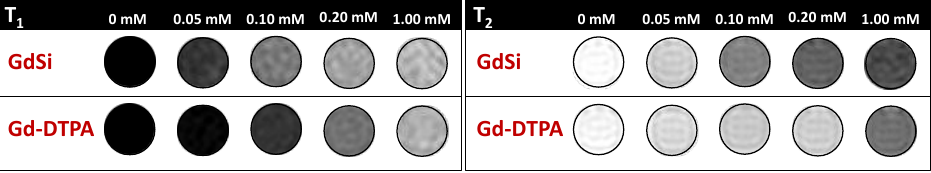
Figure 6. T 1 - weighted ( left ) and T 2 -weighted ( right ) magnetic resonance imaging (MRI) slices of GdSi aqueous solutions (0.1% xanthan gum), with varying Gd 3+ concentration, at magnetic field of 3 T and echo time of 2 ms ( T 1 ) and 203 ms ( T 2 ).